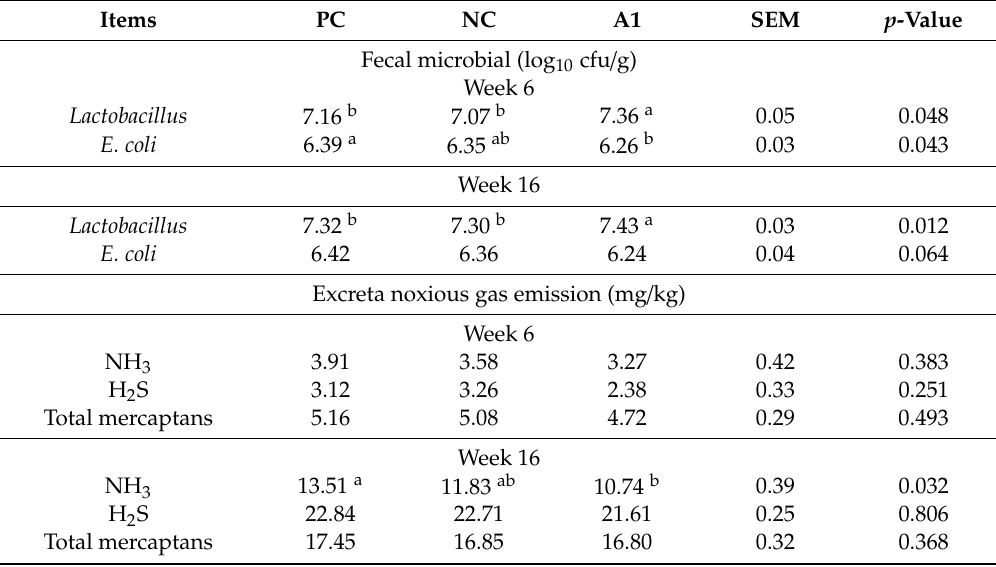
Table 4. E ff ects of dietary supplementation of enzyme blend on fecal microflora and excreta–noxious gas emissions in grower–finisher